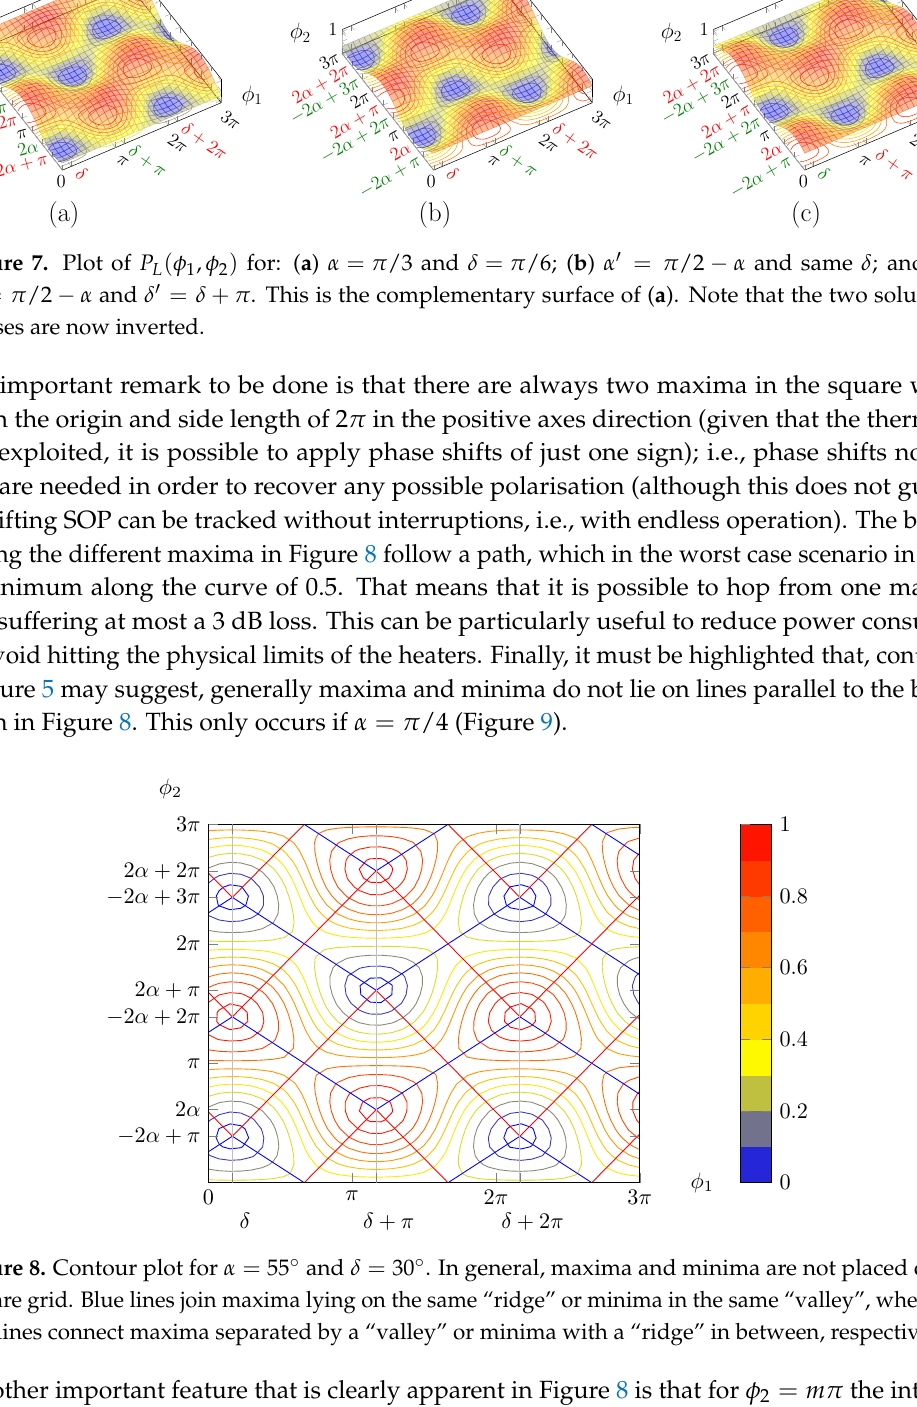
α and same δ ; and ( c ) −